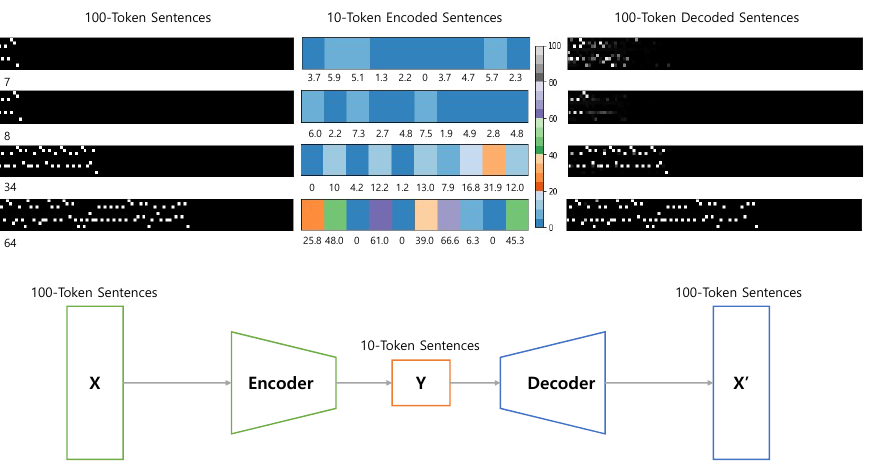
Figure 6. The retaining process of input sentences through the encoding and decoding procedure. In Figure 6, the 100-token sentences and their decoded sentences are plotted in a black box with white dots, which correspond to morphemes in a 100-token sentence. In these patterns, fewer white dots in a black array represent a shorter sentence, such as the uppermost sentence among the four instances in Figure 6. The encoder compresses a 100- token sentence into a low-dimensional 10-token sentence while removing null